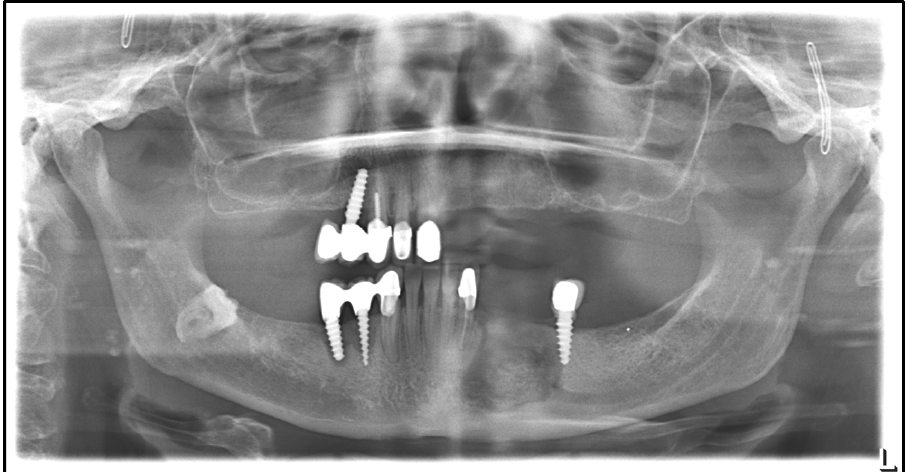
Figure 5. Dental X-ray at the time of admission with extended MRONJ of the left anterior mandible Table 2. Timeline of patient case no. 2, PSI = patient-specific implant, CAD/CAM = Computer-Aided Design and